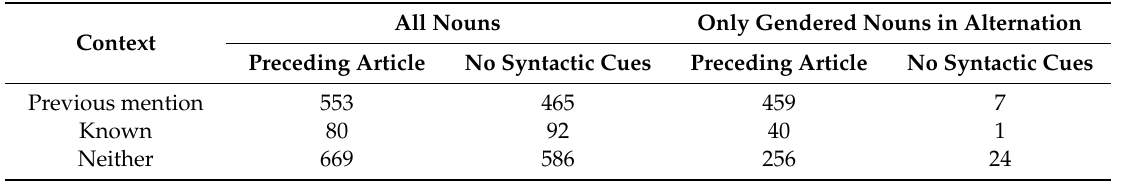
Table 7. Cross-tabulation of nouns (reported separately for all nouns and for gendered nouns in alternation) against contextual status of the